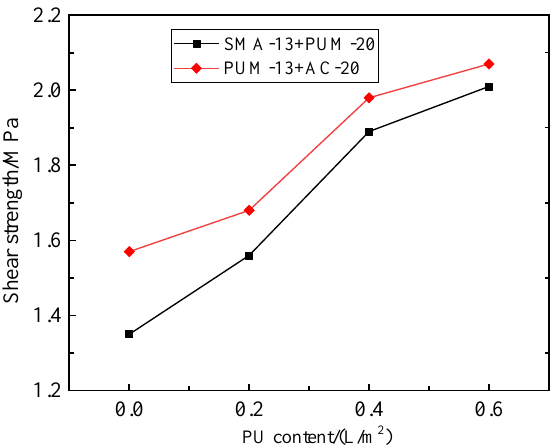
Figure 9. Specimens with a PU adhesive layer.